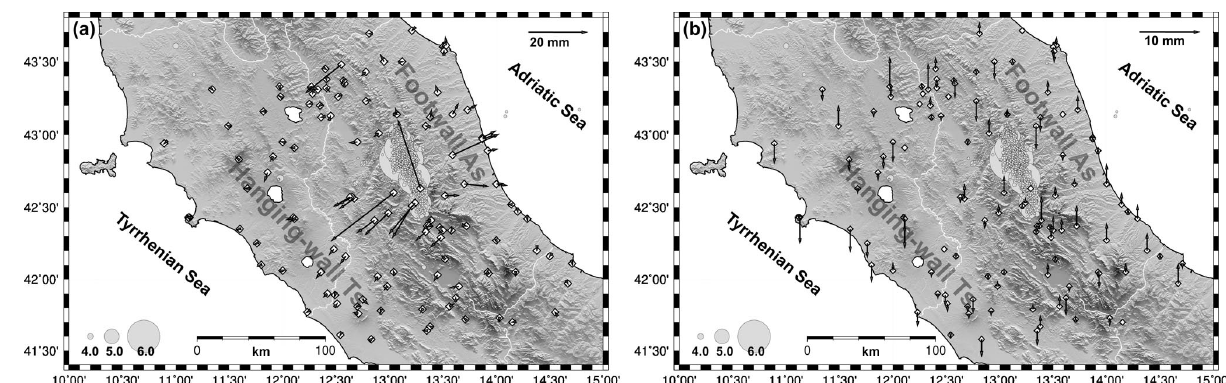
Figure 4. Horizontal (a) and Vertical (b) co-seismic displacements due to the 24 August 2016 main event. The displacements (millimetres) are estimated analysing the coordinate time series of the continuous GPS permanent stations located at a distance smaller than 100km from the epicentral area. The white diamonds indicate the locations of the CGPS sites. The epicentres of the events occurring during the period 1 June 2016–26 December 2017 are also reported in the Figure, with the circles’ size of proportional to the moment magnitude. T s = hanging-wall Tyrrhenian sector; A s = footwall Adriatic sector. (Built with the Generic Mapping Tool software GMT – Creative Commons Attribution 4.0 License.)